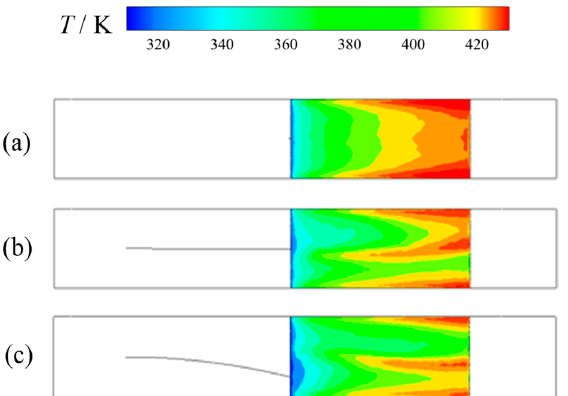
Figure 6. Relationship between Nu and Reynolds numbers.